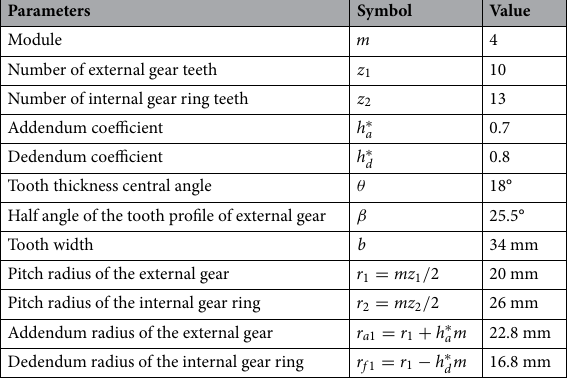
Table 2. Parameters of the gear